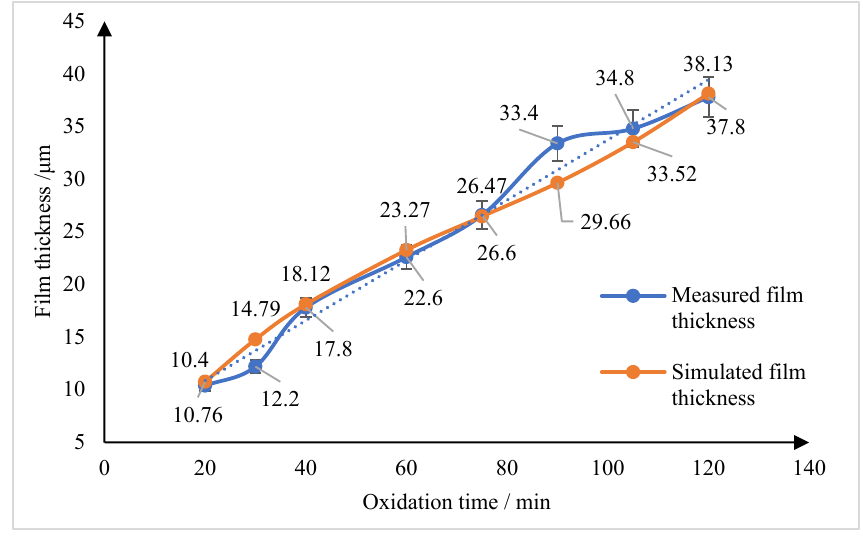
Figure 5. Measured film thickness and simulated film thickness with different oxidation time (the lines are only guidelines).